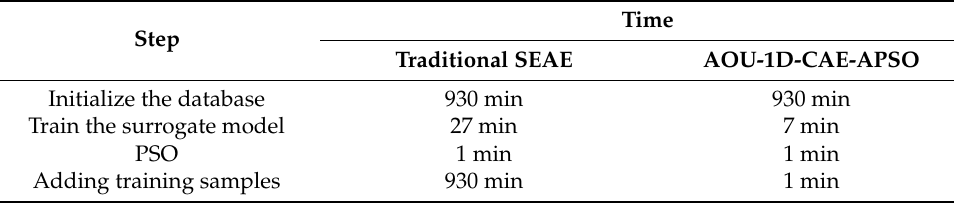
Table 2. Two surrogate model-assisted particle swarm optimization